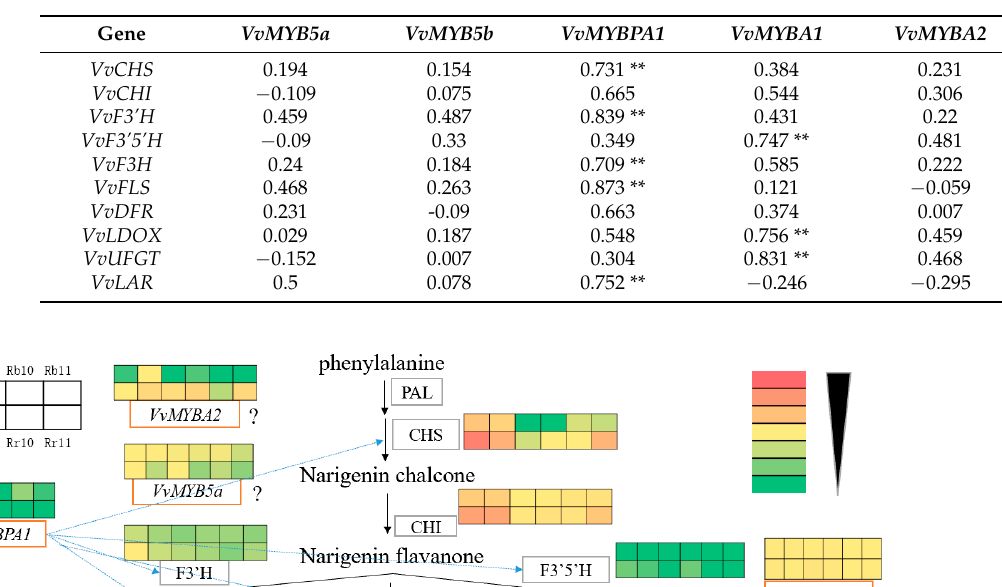
Table 3. MYB-related regulatory genes related to anthocyanin synthesis structural genes. ** represents p < 0.01.